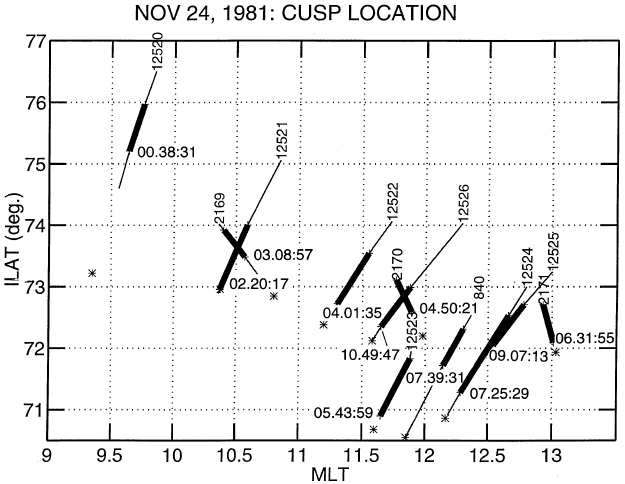
Fig. 5. Cusp crossings by AUREOL-3 (pass 840N), NOAA-6 (passes 12 520 to 12 526) and NOAA-7 (passes 2169 to 2171) on November 1981, plotted in the MLT-ILAT frame. The ‘‘cusp proper’’ crossings, i.e. the regions where the ion energy flux exceeds 10 ) 3 erg (cm 2 s) ) 1 are shown as heavy lines , while the cusp region with the ion energy flux >10 ) 4 erg (cm 2 s) ) 1 as light lines . Note that the invariant coordinates of the NOAA satellites, taken from Despirak et al. (1994), were again computed by the CADR-4 program to make them comparable to the coordinates used for the A3 pass. Trapping boundaries of >30 keV electrons are indicated by